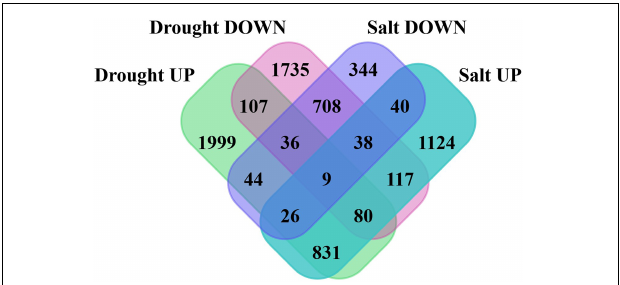
FIGURE 1 | Venn diagram showing the number of shared and unique genes in differentially expressed genes (DEGs) of drought and salt stress data. In order to make drought and salt stress-responsive (DSSR) genes set compendium, we focused on 3,841 and 1,508 DSSR uniquely differentially expressed genes in drought and